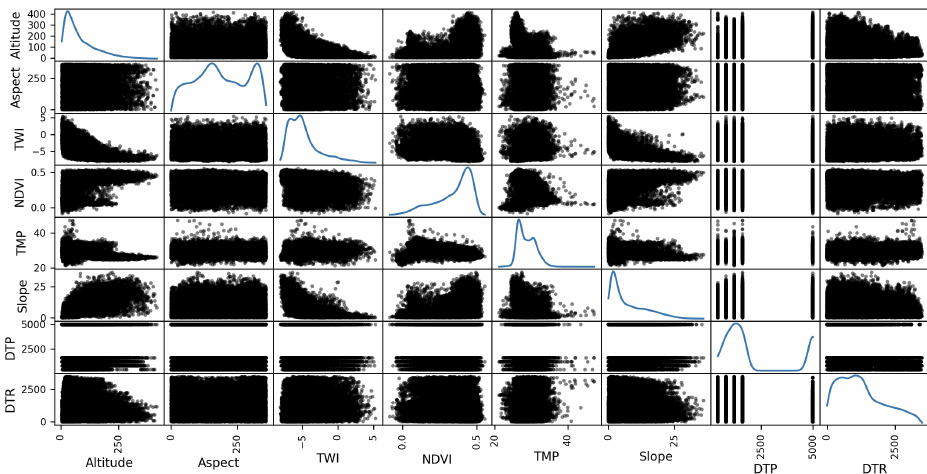
Figure 5. Scatter plot of forest fire influencing